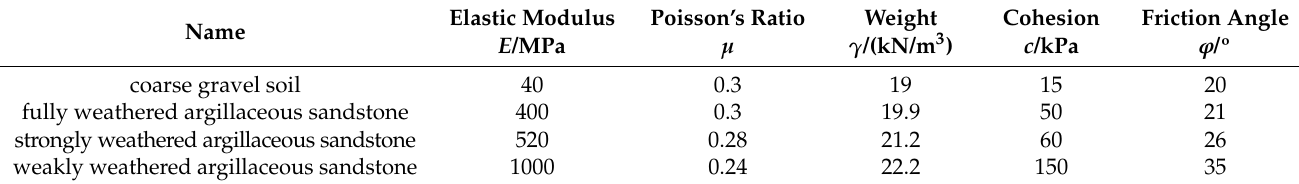
Table 1. Physical and mechanical calculation parameters of surrounding rock.